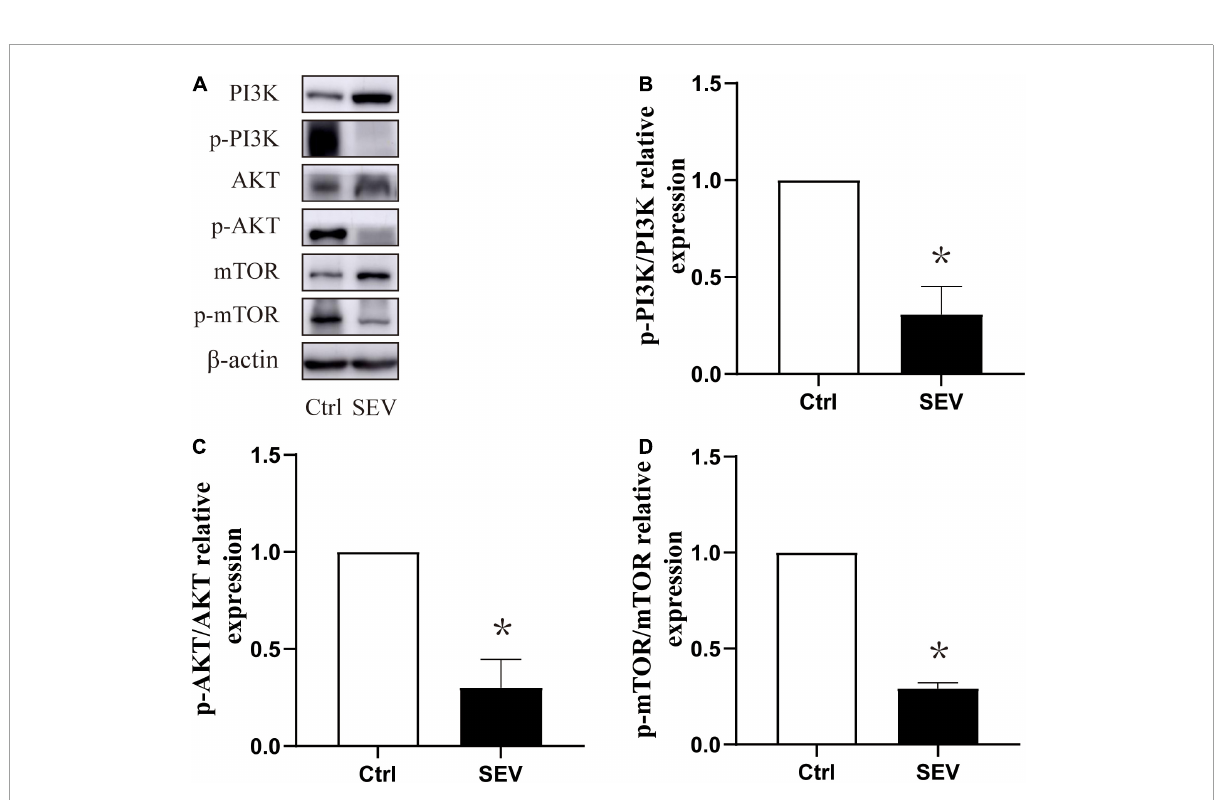
FIGURE3 Sevoflurane can suppress the phosphorylation expression of the PI3K/AKT/mTOR pathway in the hippocampus in neonatal mice. (A) Representative Western blots of PI3K, AKT, and mTOR. (B–D) Bars represent normalization of target proteins were ratio of phosphorylated and non-phosphorylated forms. The quantitative analysis of PI3K, AKT and mTOR when exposure to sevoflurane after 6 h by one-way ANOVA. Results are the means ± SD. n = 6 in each group. * P < 0.05 vs. Ctrl.